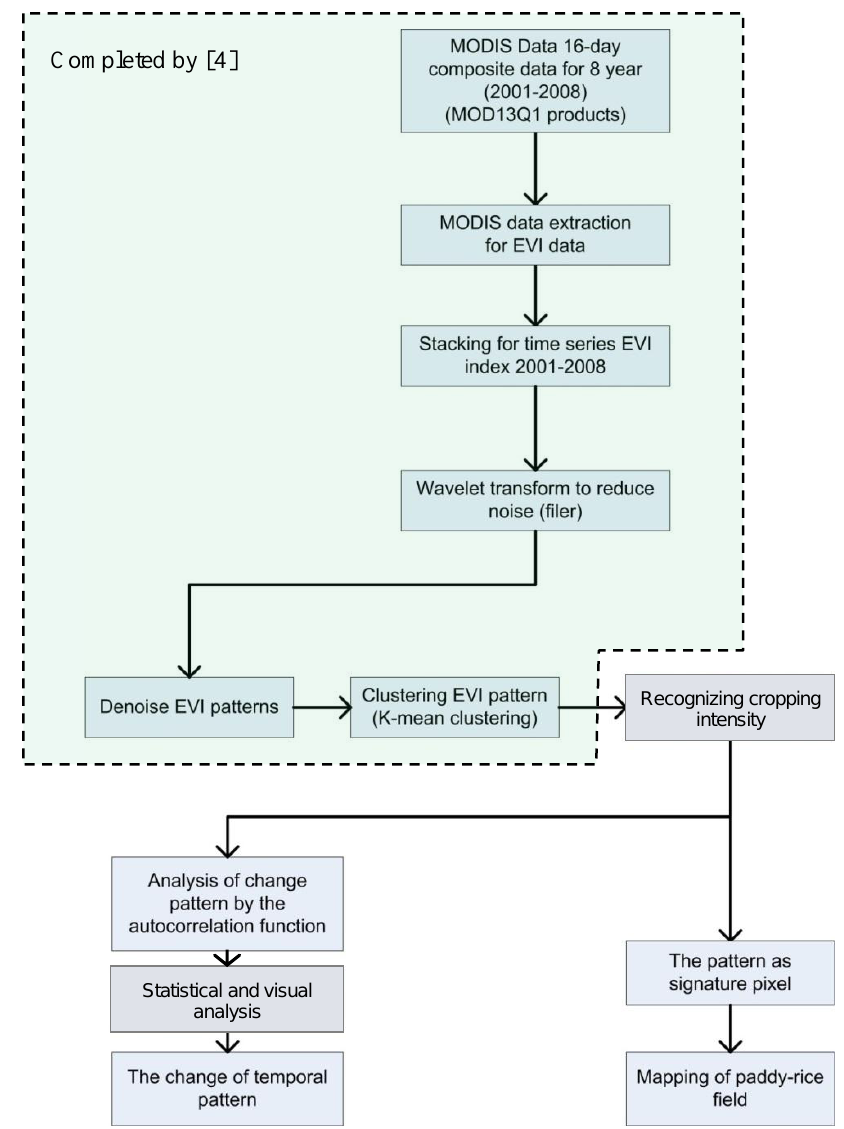
Figure 2. Flow of data handling and image